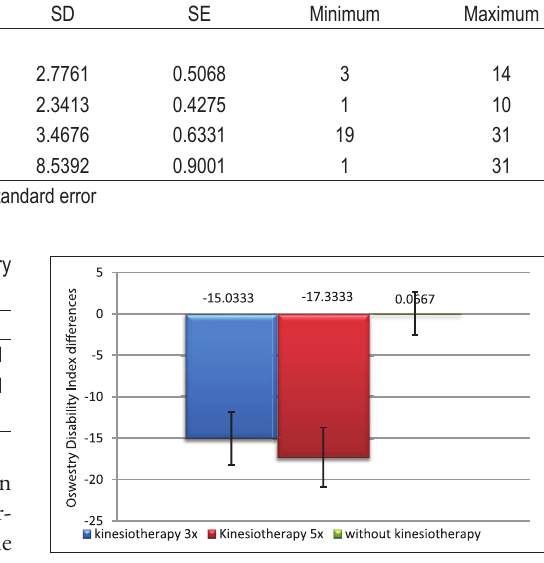
FIGURE 2. Average values of the oswestry disability index differ‑ ences before and after